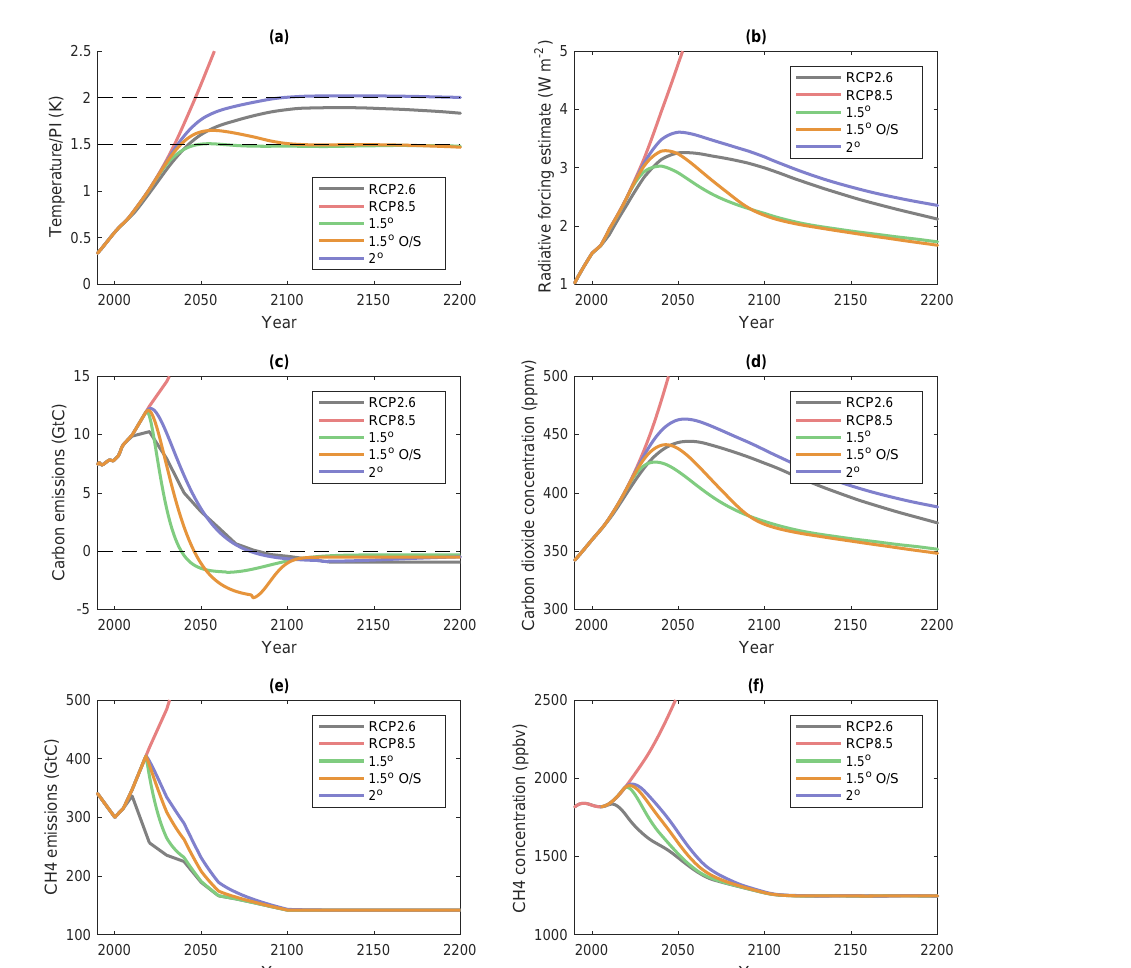
Figure C1. New scenarios used for this study. Panels (a) shows the predicted global mean temperature evolution, (b) shows the radiative forcing evolutions, (c) shows net anthropogenic carbon emissions (fossil fuel and land use combined), (d) shows CO 2 concentrations, (e) shows methane emissions and (f) shows the methane concentrations. Blue, green and orange lines are 2, 1.5 and 1.5 ◦ C overshoot